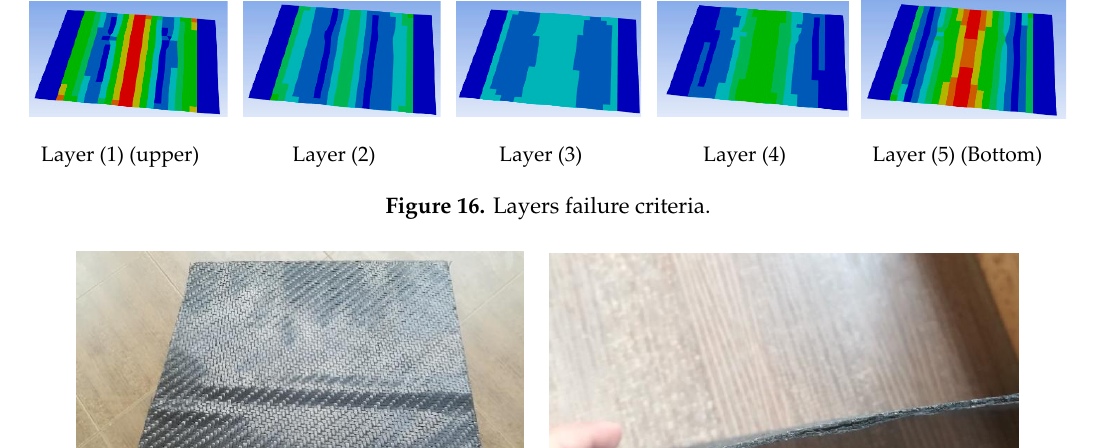
Figure 15. Simulation of the composite plate using ANSYS software. ( a ) The simulation, ( b ) Total deformation.